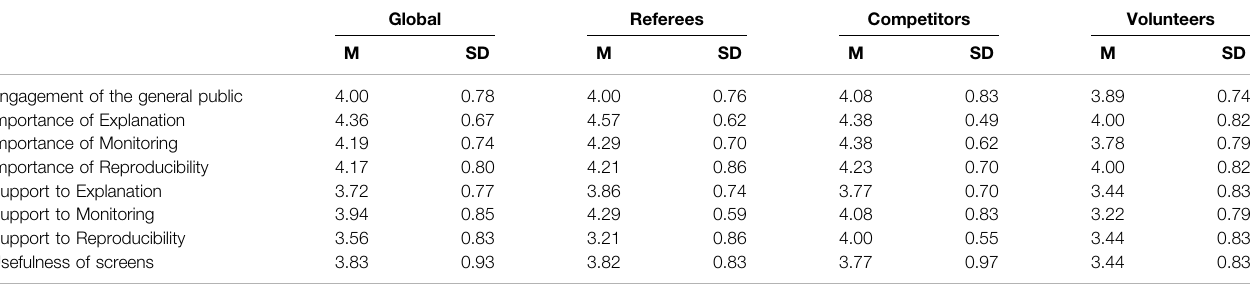
TABLE 1 | Summary of the results of the part one of the questionnaire. The table includes the mean (M) and the standard deviation (SD) of each question. The values are aggregated globally and by actor. Global